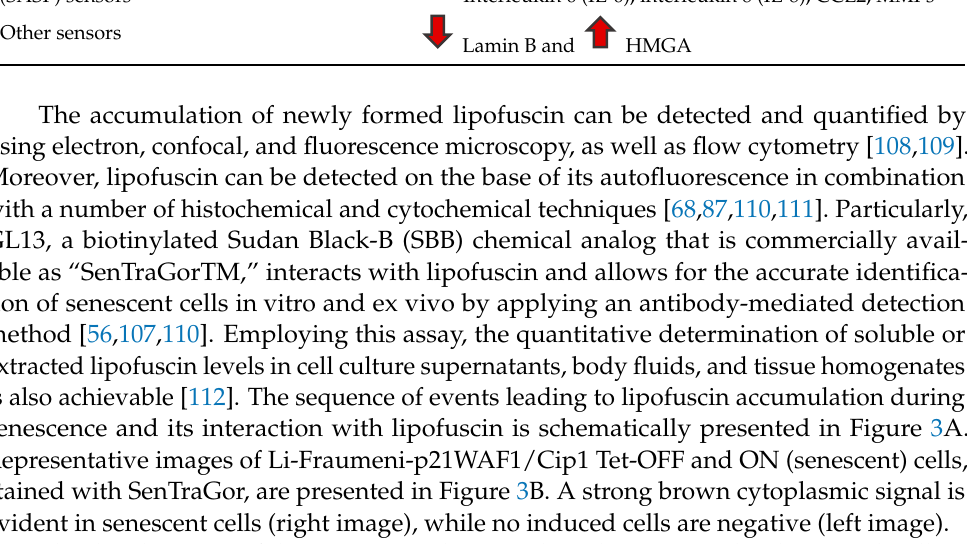
Table 1. Detection markers of cellular senescence sensors [107]. Up arrows indicate an increase, down arrows, a decrease.